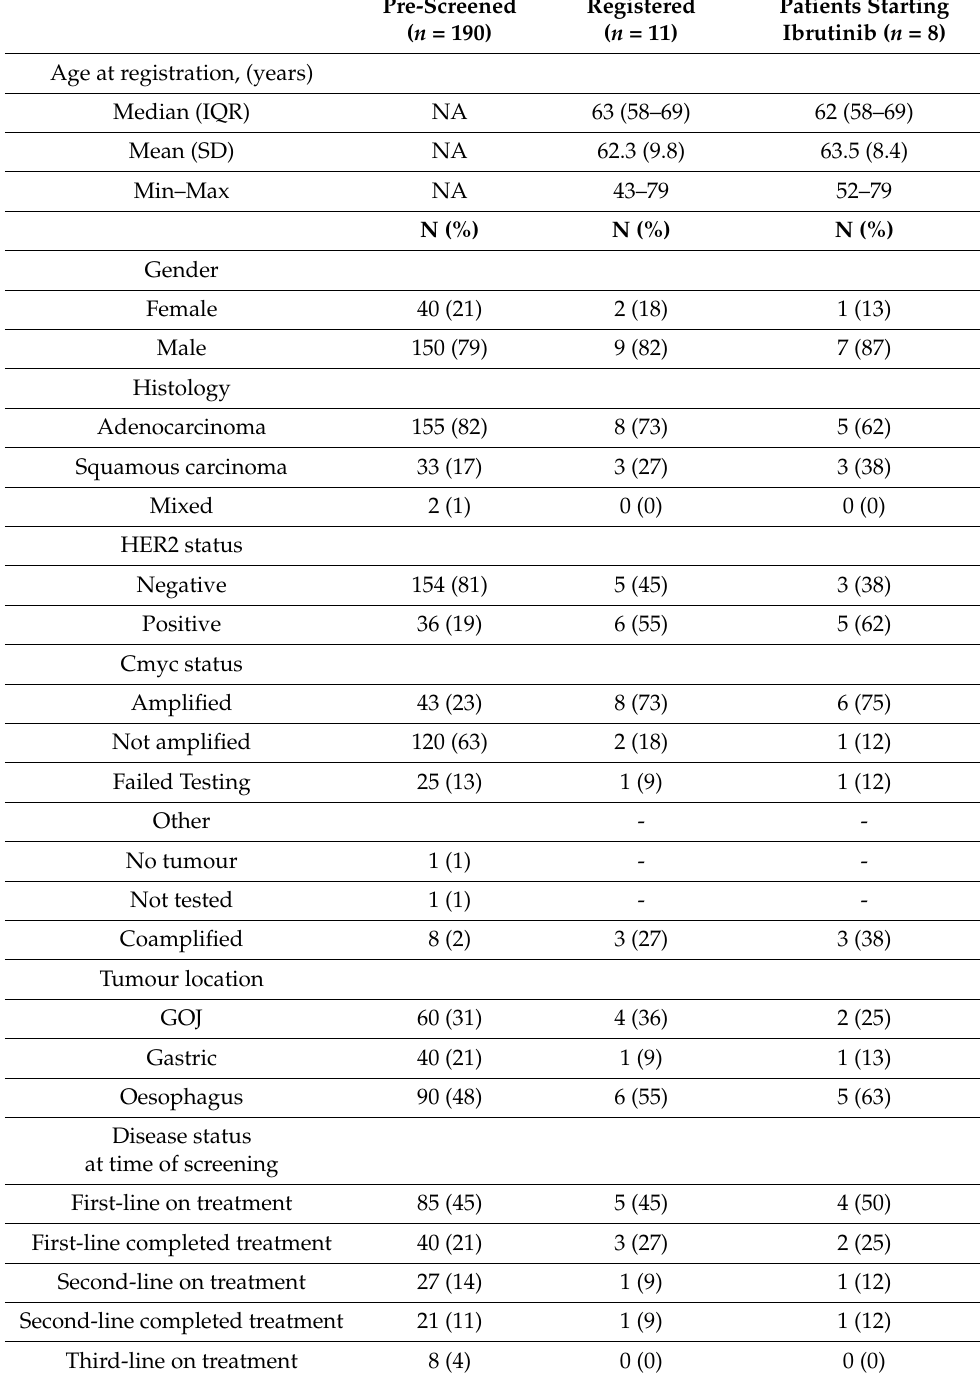
Table 1. Characteristics of 190 patients who were pre-screened for a c-MYC and/or HER2 amplification.